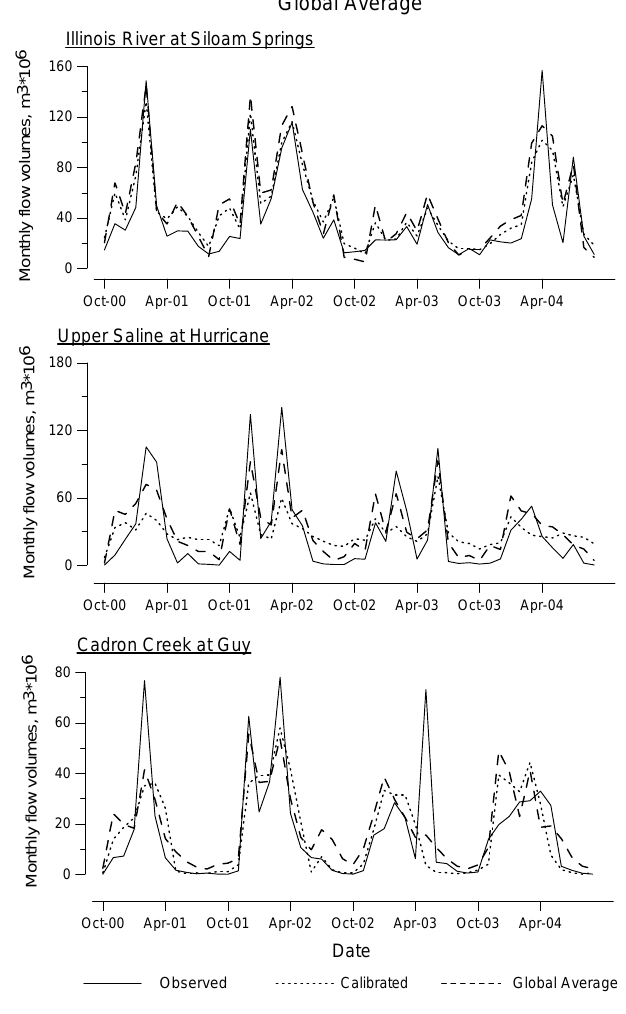
Figure 2. A comparison between global average-based and calibration-based stream flow hydrographs for selected stations within the test watersheds for the period October 2000– September